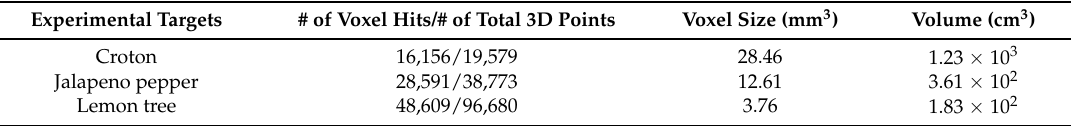
Table 4. Volumes of these three